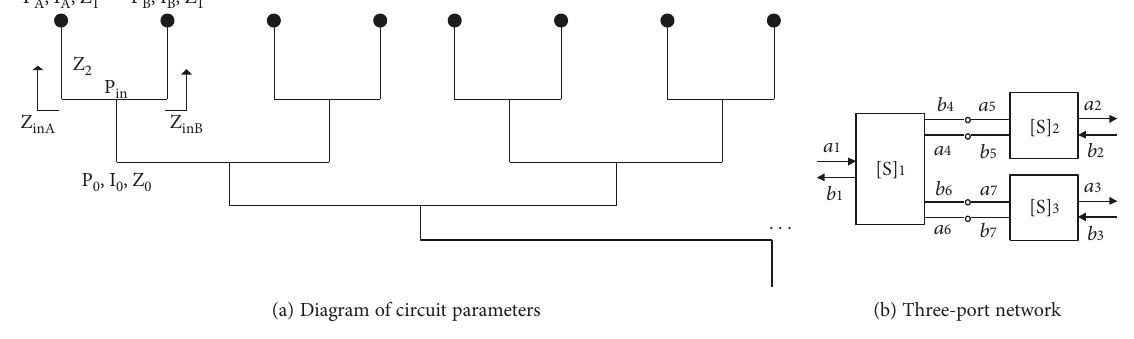
Figure 4: Diagram of the power